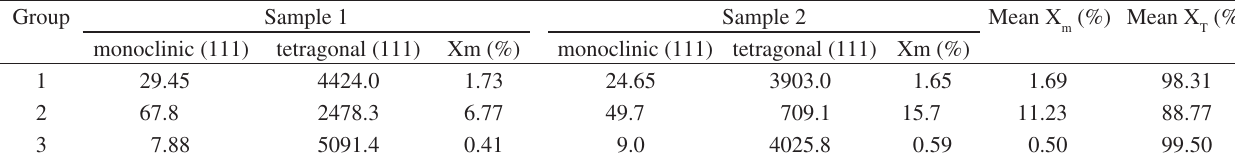
Table 3. Amounts of transformed zirconia monoclinic after the three different mechanical surface treatments.